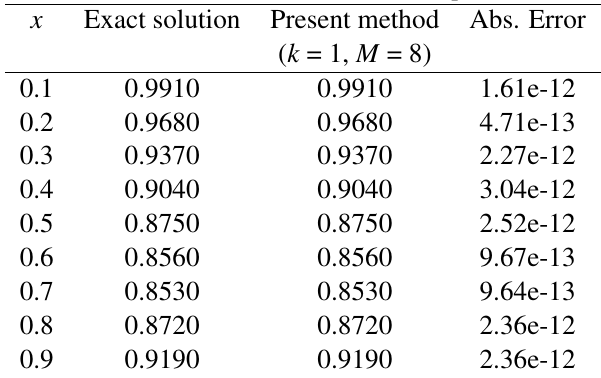
Table 1 Numerical results of example 1.